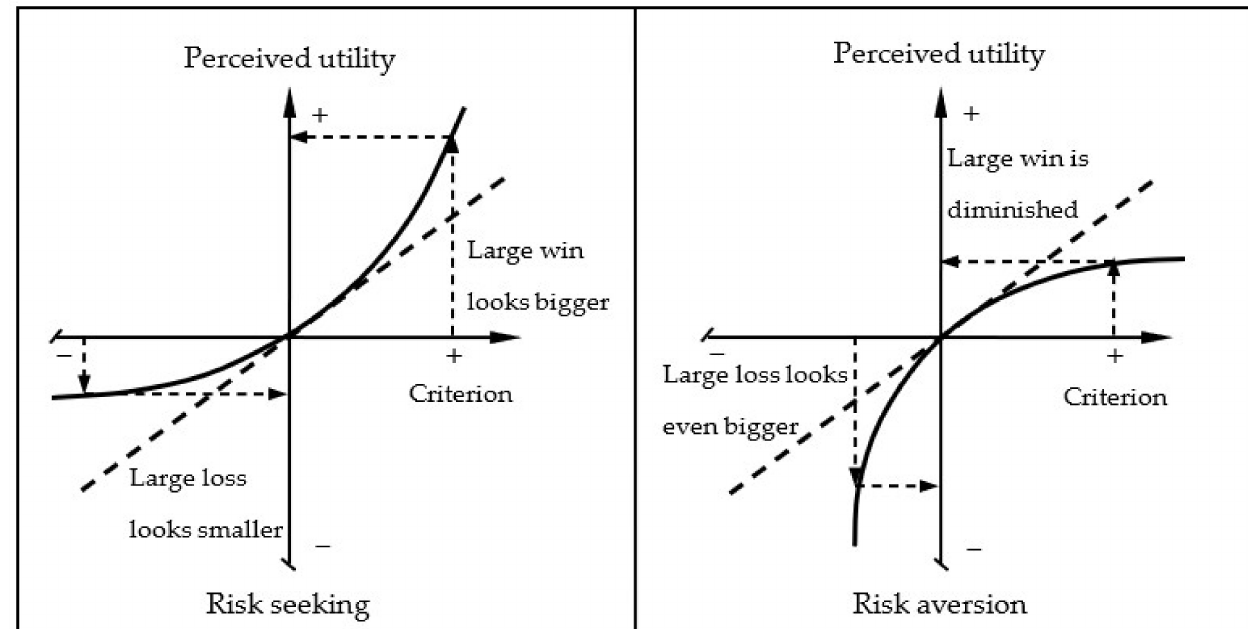
Figure 2. Utility return curves of different attitudes to risk [12]. The 45 ◦ dotted line in each figure is the utility benefit of a neutral risk